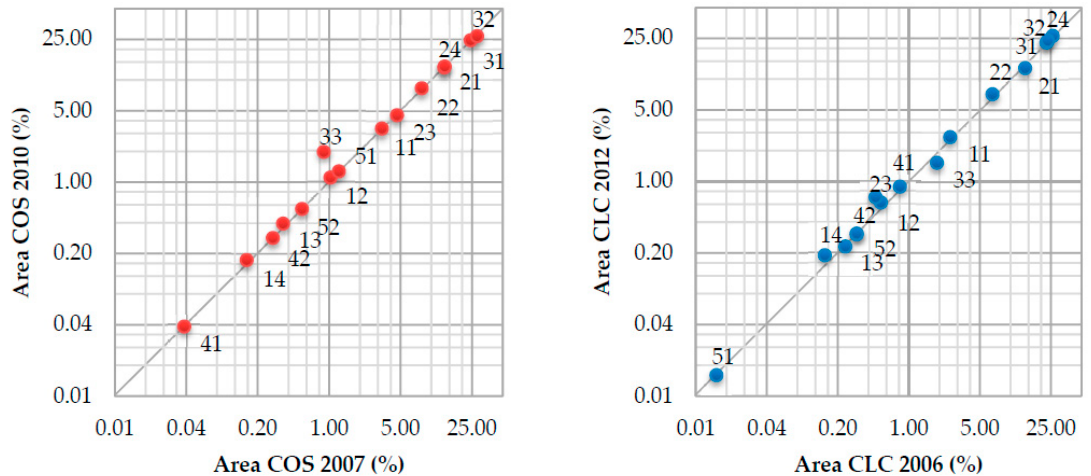
Figure 2. Land use and land cover (LUC, total area) of mainland Portugal in different years, obtained by COS and CLC (vector geoinformation). LUC codes: See legend in Figure 1.